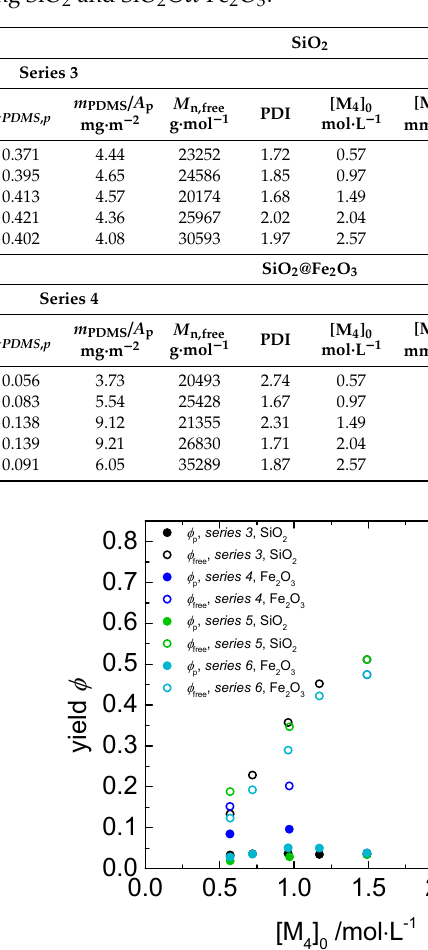
Table 1. Polydimethylsiloxane (PDMS) content µ PDMS,p molar mass of free polymer M n,free and PDI for the SI–ROP of M 4 for the variation of solvent (Series 3 and 4) and the variation of monomer amount (Series 5 and 6) using SiO 2 and SiO 2 @ α -Fe 2 O 3 .